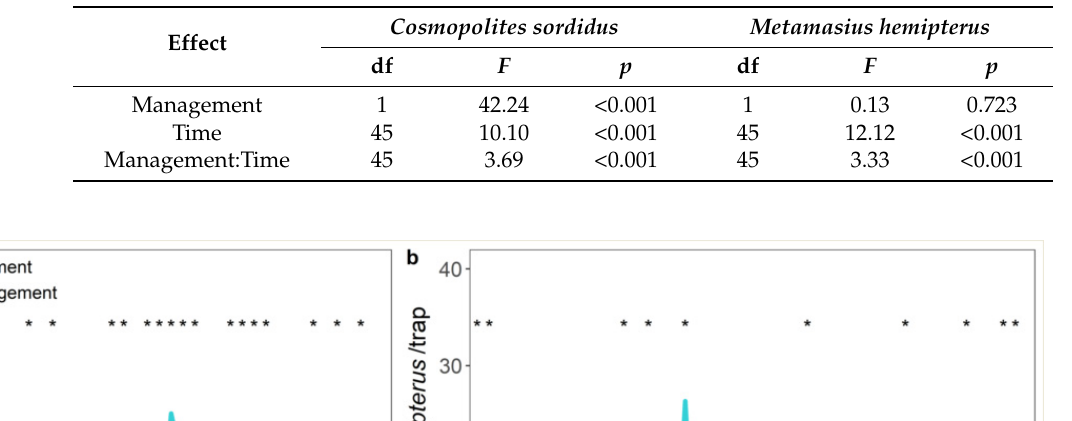
Table 1. Summary of analysis of variance for repeated measures of weevil borer ( Cosmopolites sordidus , WB) and false weevil borer ( Metamasius hemipterus , FWB) populations between managed and unmanaged plots located in the municipality of Teixeiras, Minas Gerais state, Brazil, assessed